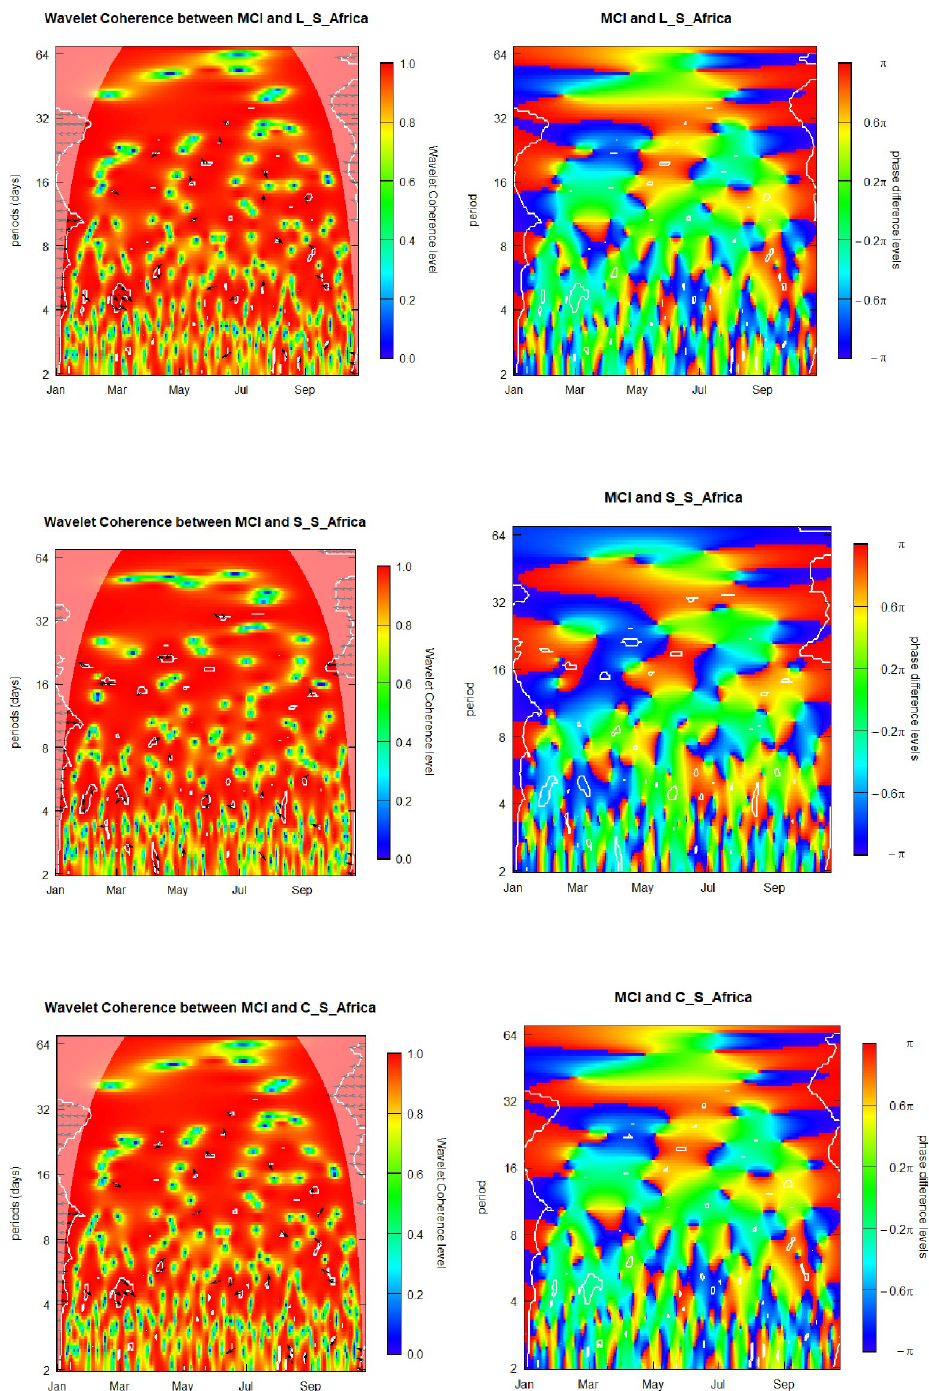
Fig 5. Media Coverage Index (MCI) and sovereign yield components of South Africa. L_S_Africa, S_S_Africa, and C_S_Africa denote the level, curvature and slope component for South Africa. pattern of the SWC heatmap for the MCI-Slope_S_Africa is somewhat different from the pre- viously discussed slope-factor heatmaps, indicating that there is an attractive diversification